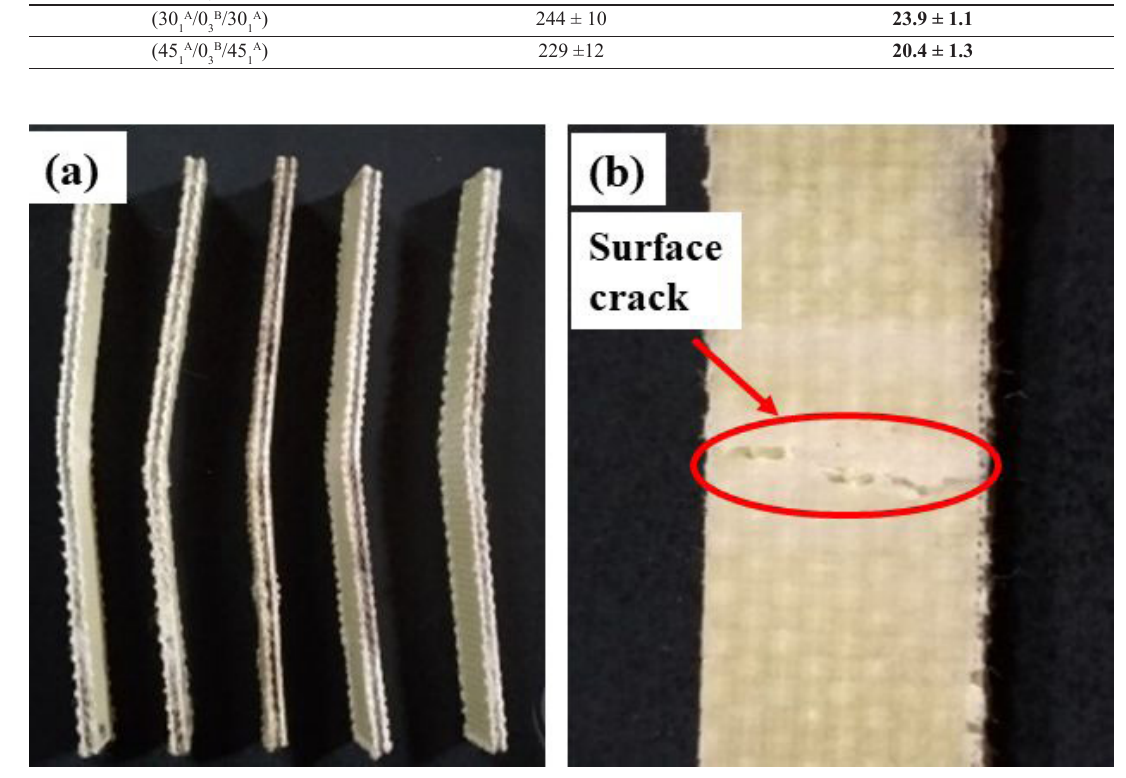
Figure 9. (a) Flexural test specimens after the test (b) Enlarged view of crack on the back